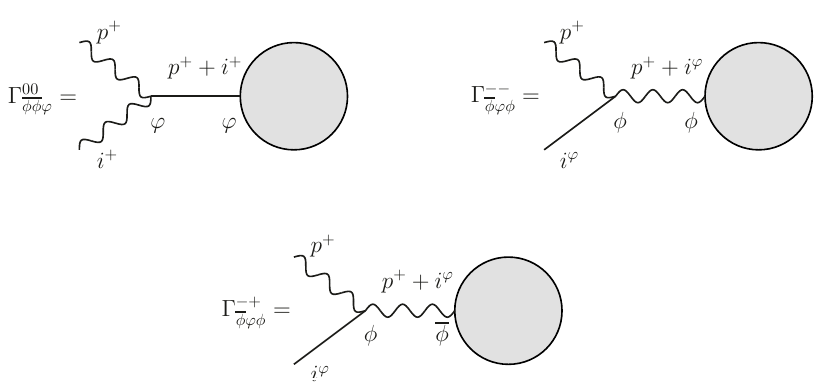
Figure 3 . The contribution of graphs with a nontrivial single vector soft limit.